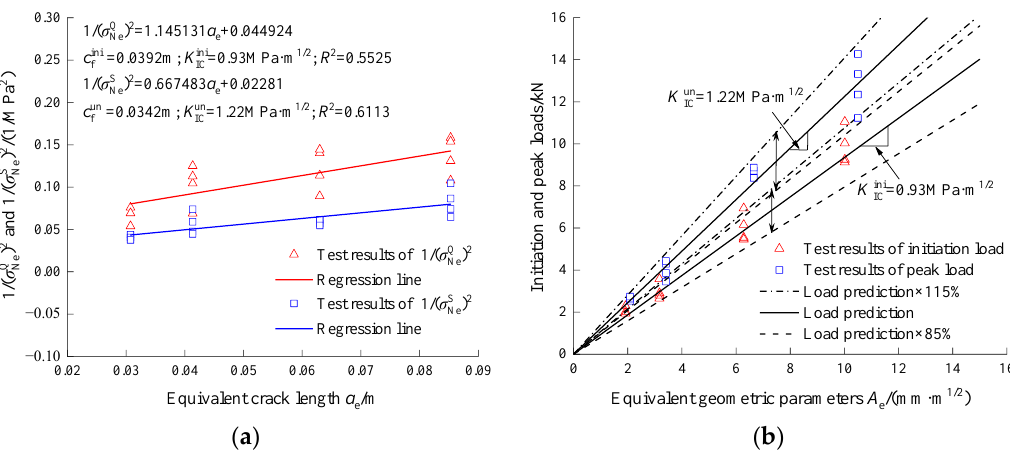
Figure 16. ( a ) Linear relationship of the size effect model; ( b ) predictions of initiation and peak loads. After calculation, the w 0 obtained in this experiment is 150 µ m, and the minimum value of MAPE of unstable toughness is 8.19%. Figure 17 shows the fracture toughness predicted results of specimens with different initial α c value when the effective height of the specimen is 0.3 m. It can be seen from Figure 17 that the calculation results of K Q IC and K S basically decrease with an increase in the initial α c , and most of the test results are within the allowable error range of ± 15% of the predicted value. MAPE = 8.19%, RMSE = 0.16 MPa · m 1/2 , a 15 = 73.33% and Cov = 0.0003 ( MPa ) 2 m of the corresponding K S predicted results. The above indices show that the determination method of fracture parameters based on the size effect model and fracture extreme theory can realize the accurate prediction of initiation and unstable toughness when the size or α c changes.